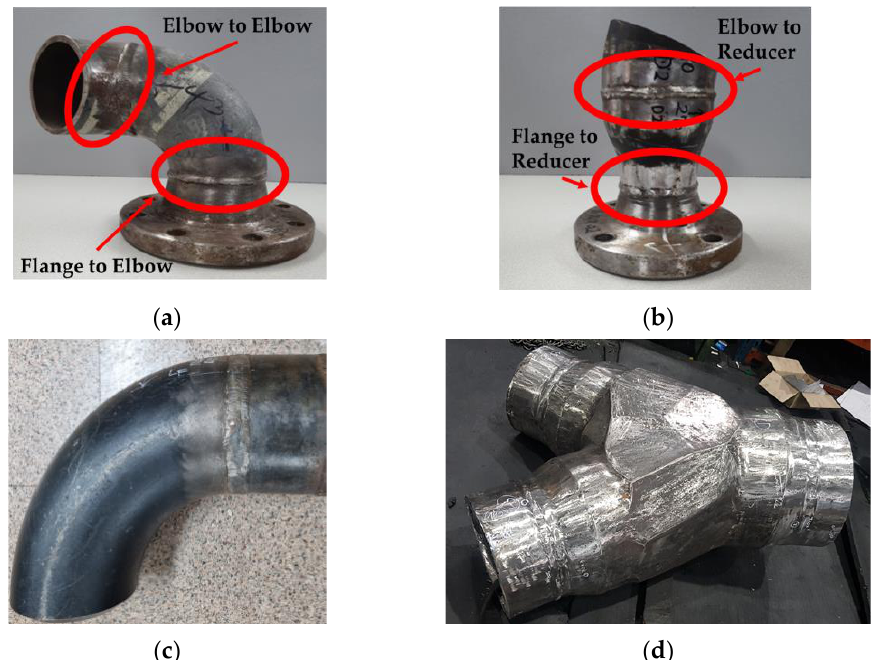
Figure 17. Actual mock-ups utilized to obtain experimental data: ( a ) 100 mm curvature pipe with elbow–flange construction geometry; ( b ) 75 mm, 100 mm curvature pipe with elbow–flange–reducer construction geometry; ( c ) 150 mm curved pipe with tapered elbow construction geometry; ( d ) heavy wall pipe with taper formed on the surface of a 300 mm, 400 mm specimen. Table 5. The dimension of the defects presents inside each specimen.